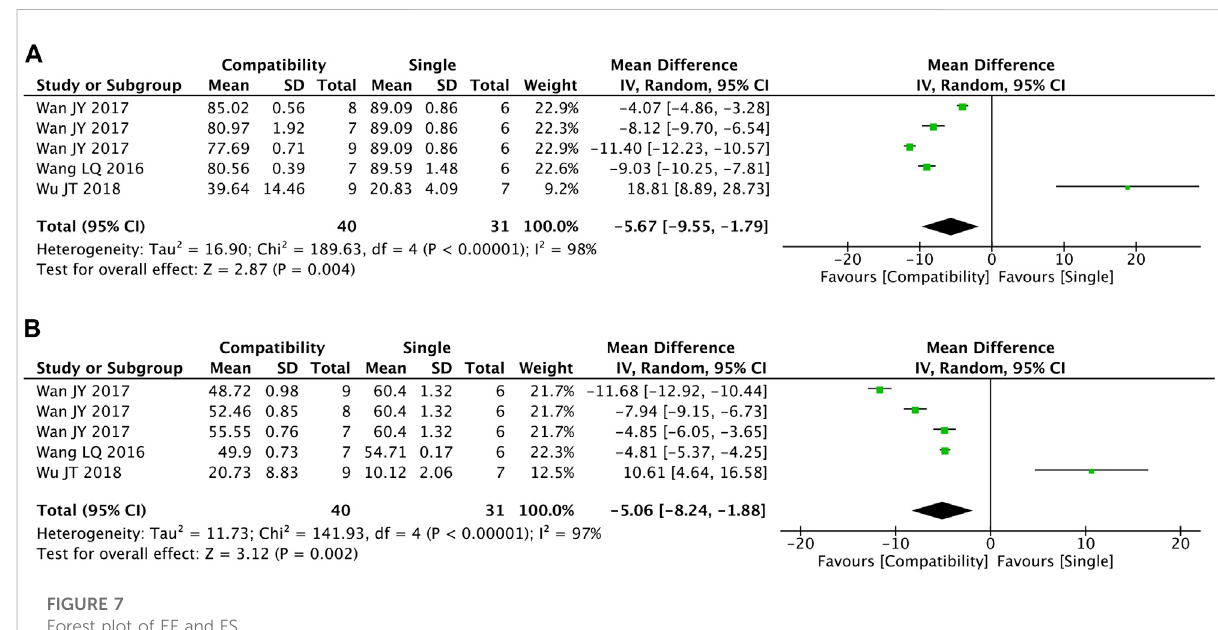
FIGURE 7 Forest plot of EF and